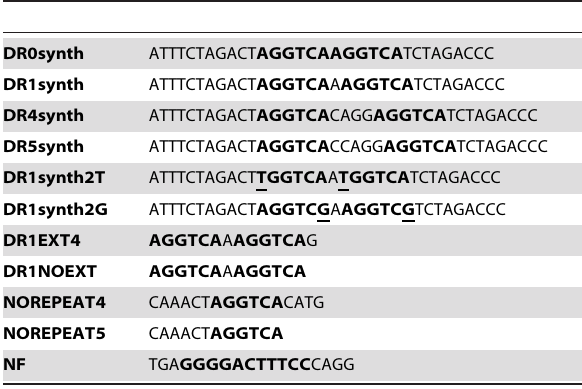
Table 1. Different responsive elements used for in vitro BRET shift assays.